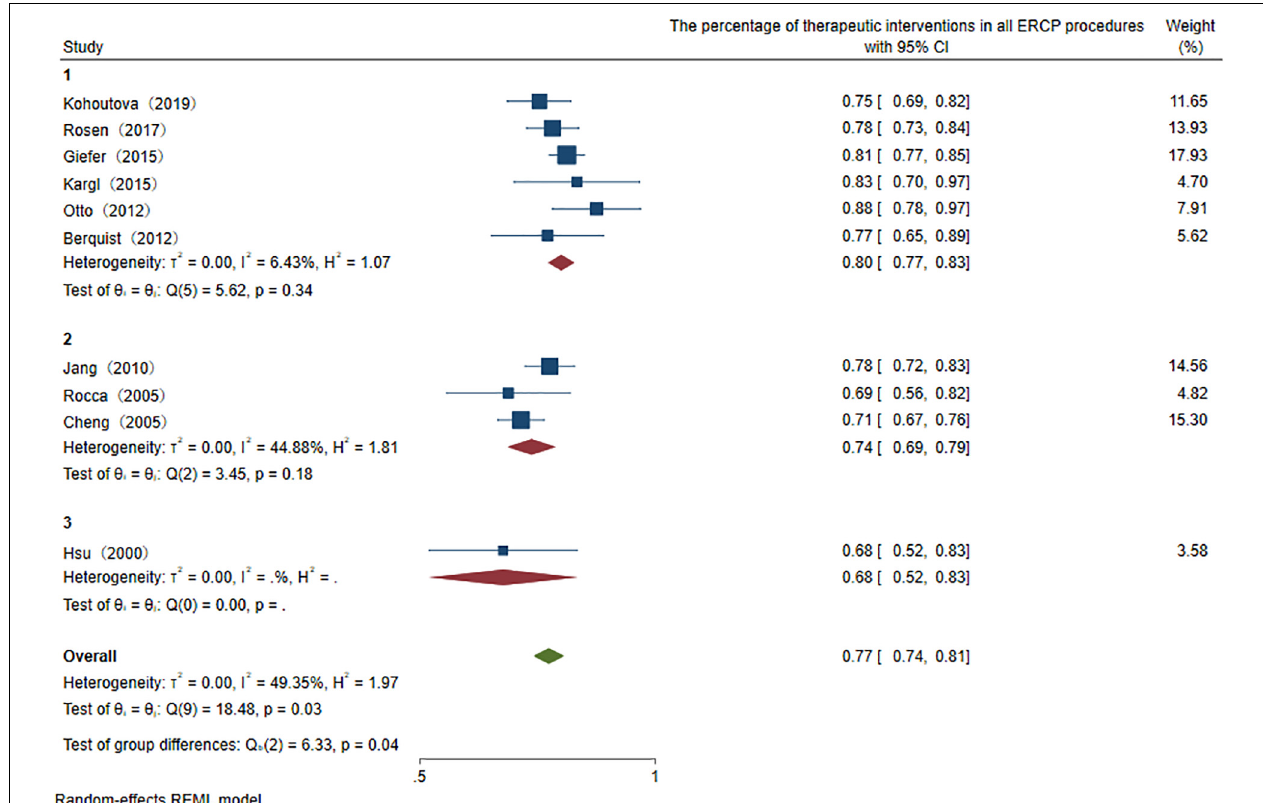
FIGURE 4 | Subtype analysis of publication year of the percentage of therapeutic interventions in all ERCP procedures.